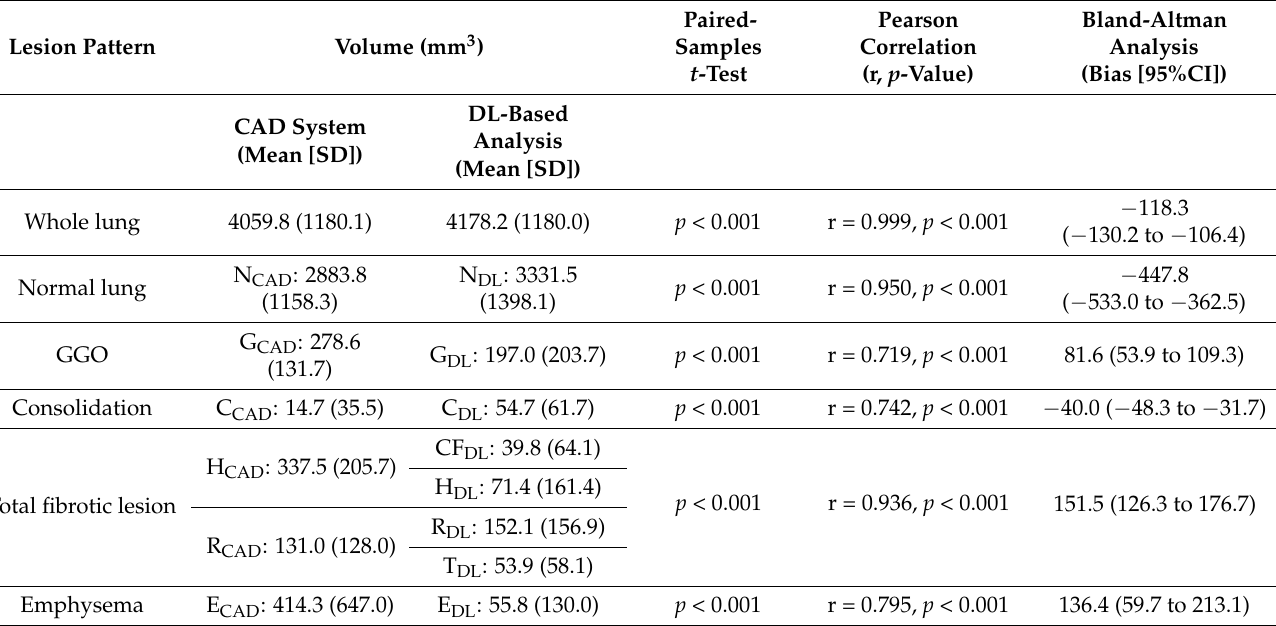
Table 3. Descriptive Outcomes and Method-Comparison Analysis for the Quantification of CT Images using the CAD system versus DL-based